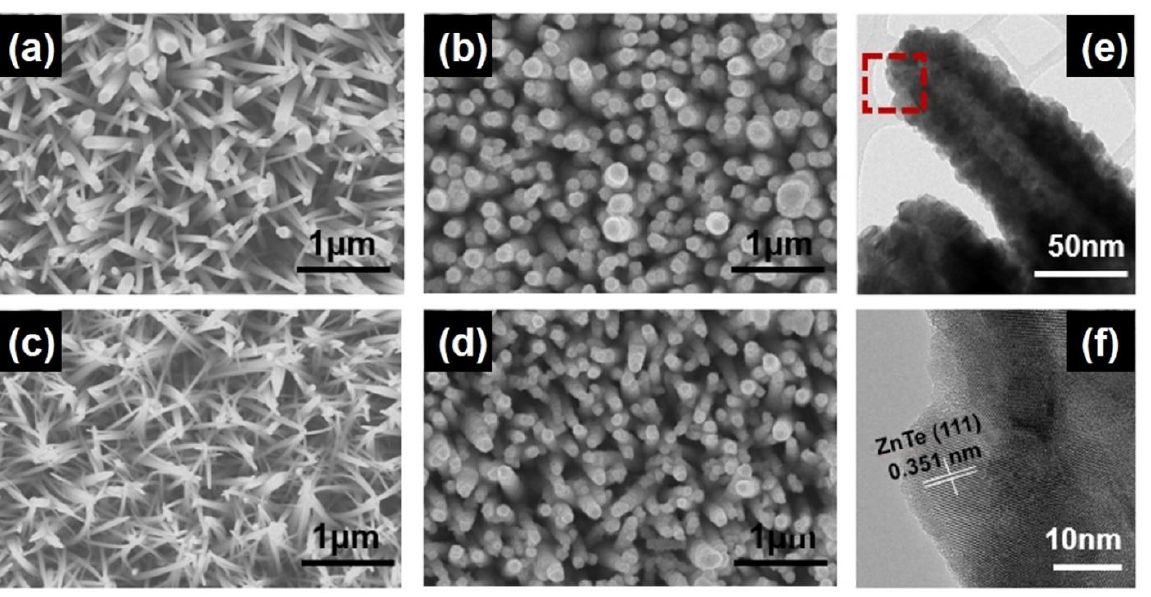
Figure 2. SEM images for ( a ) ZnO, ( b ) ZnTe, ( c ) Al:ZnO, and ( d ) Al:ZnTe. ( e ) HR-TEM results for Al:ZnTe, and ( f ) the magnified view of the region within the red box in ( e ).